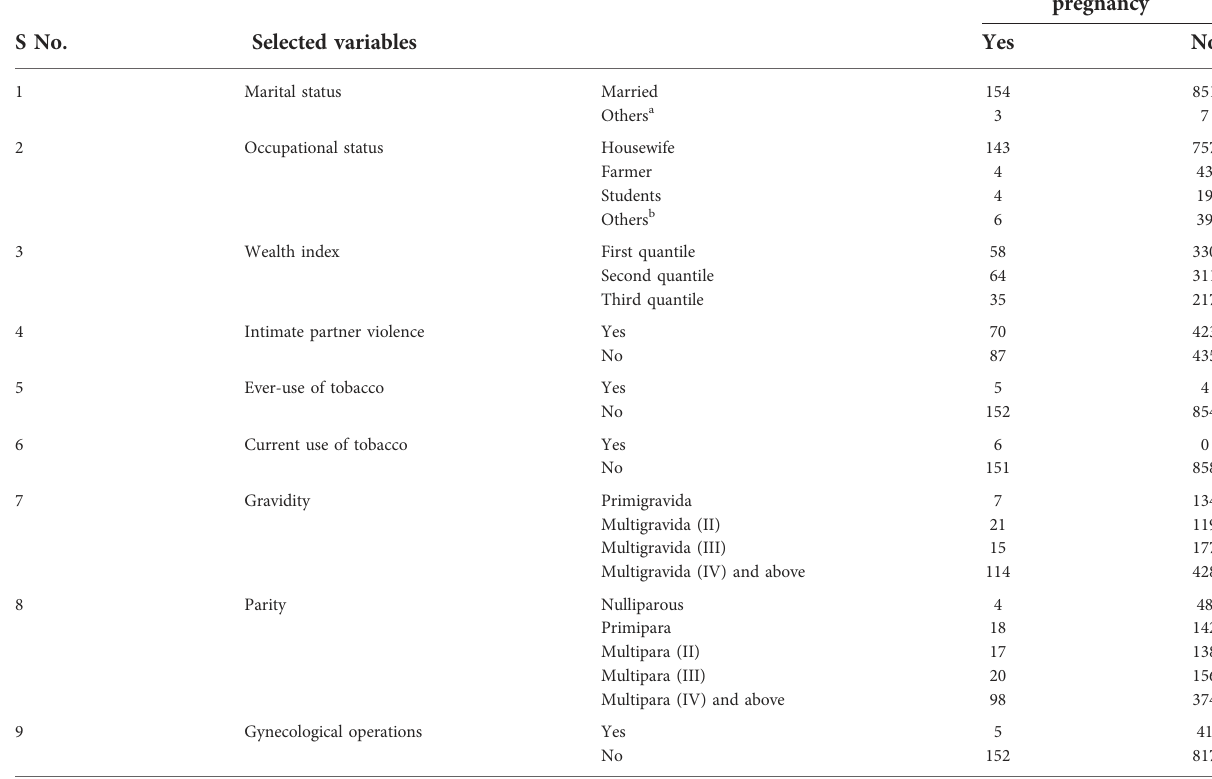
TABLE 4 Selected variables and the magnitude of khat use during pregnancy at Kersa and Haramaya HDSS sites, 2021 ( n =1,015).